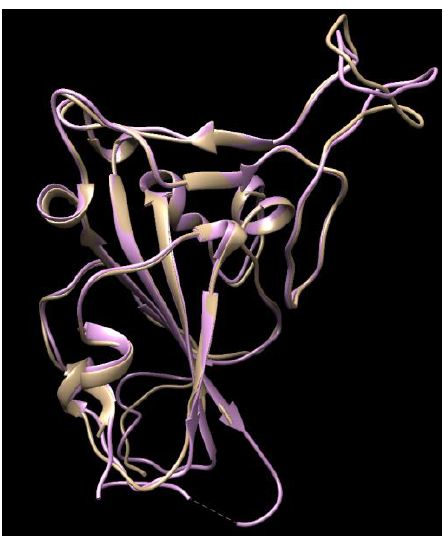
Figure 1. The comparison of the crystal structures of the SARS-2 spike protein (6VW1, pink color) with our homology modeling (light brown color) using the SARS-2 template.